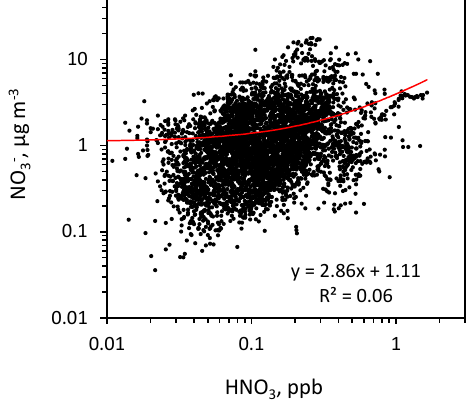
Fig. 12. Relationship of nitrate and nitric